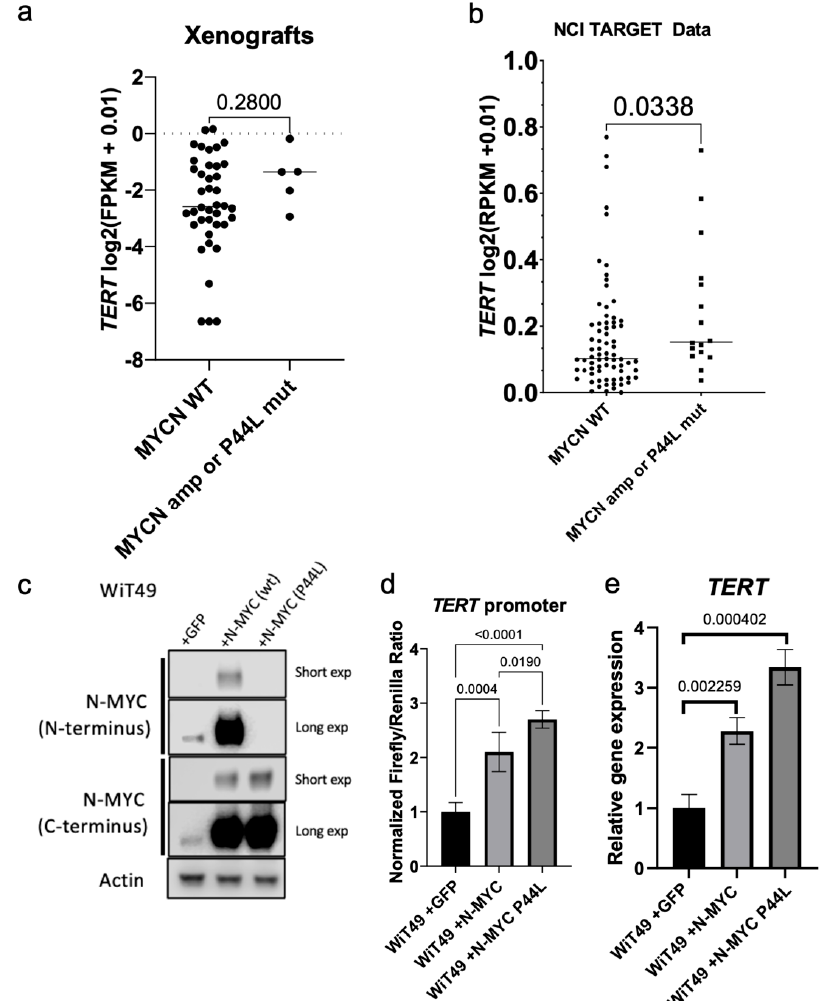
Figure 6. Relationship between WT1 and MYCN in Wilms tumor. ( a ) TERT expression in MYCN wildtype xenografts versus MYCN amplified or P44L mutant samples (Mann Whitney test p = 0.280). ( b ) TERT expression in diploid, MYCN wildtype samples and those with MYCN amplification or P44L mutation in the NCI TARGET data ( p = 0.0338). ( c ) Overexpression of wild type N-MYC and N-MYC P44L in WiT49 cells. The P44L mutation alters the recognized N-MYC (N-terminus) antibody epitope. The N-MYC (C-terminus) antibody detects overexpression of N-MYC in both condi- tions. Short exp—short exposure; Long exp—long exposure. Overexpression of wild-type N-MYC results in increased ( d ) TERT promoter activity and ( e ) TERT transcription by qRT-PCR. Overex- pression of P44L mutant N-MYC results in increased ( d ) TERT promoter activity and ( e ) TERT tran- scription relative to wild type N-MYC and empty vector control (two-tailed t -test p values shown). Original labeled images of all Western blot and PCR gel data can be found at File S3.